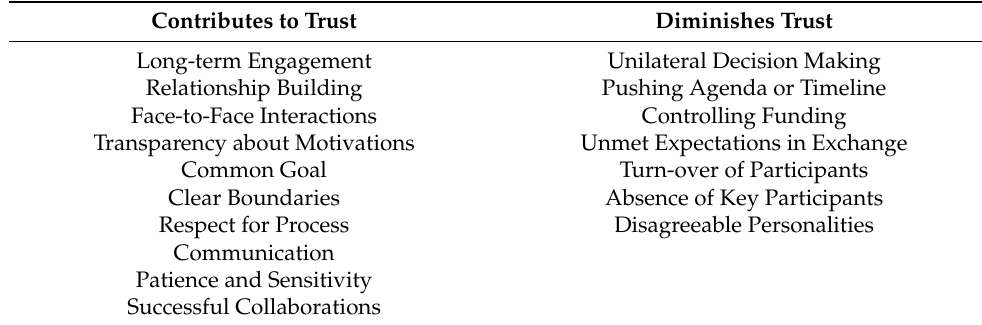
Table 1. Factors that contribute to and diminish